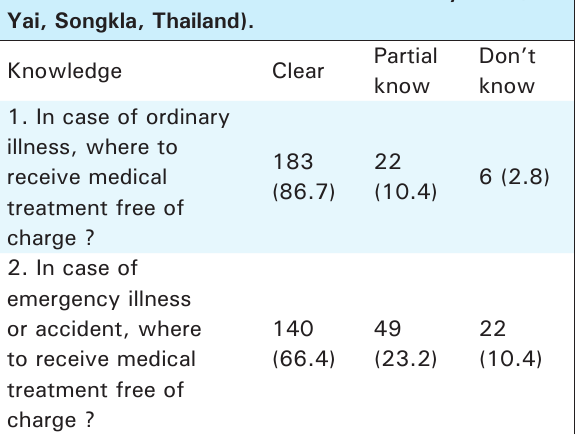
Table 5. Awareness of Health Insurance System (Hat Yai, Songkla,